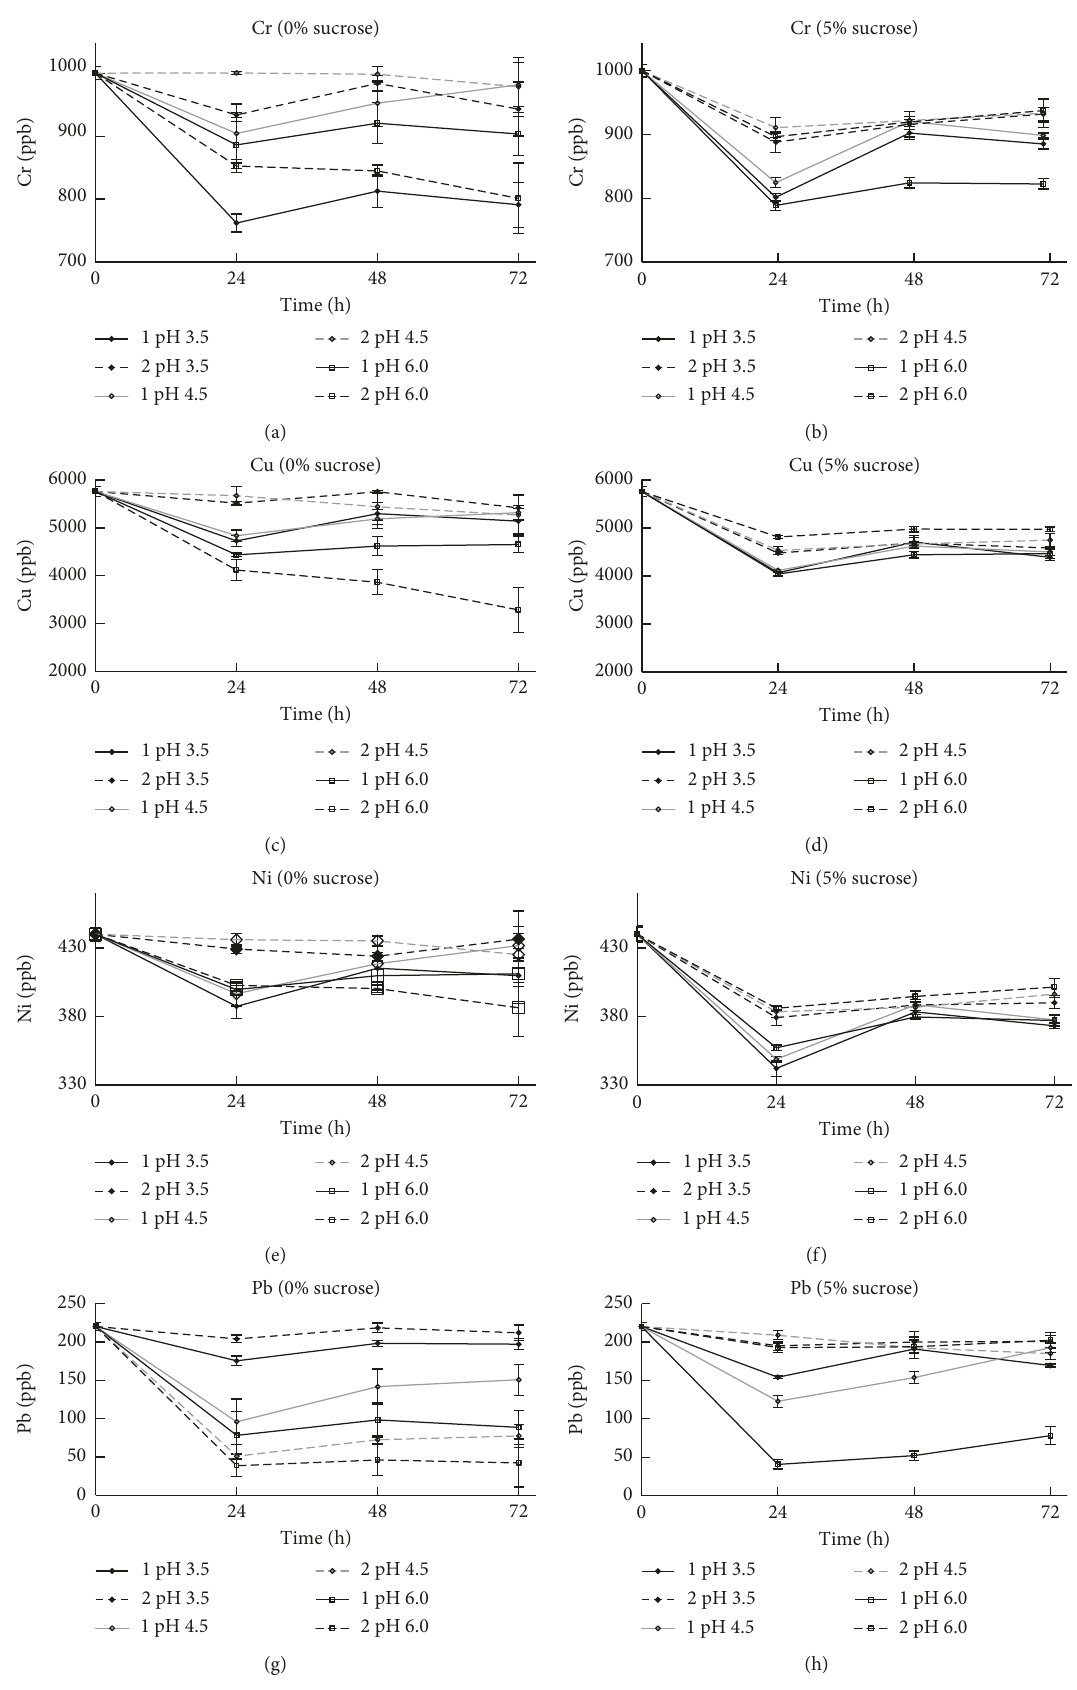
Figure 4: Cr, Cu, Ni, and Pb concentration as a function of time in absence and presence of sucrose (5%) for Colonies 1 and 2. Conditions: 5 · 10 –3 M citrate buffer, initial pH � 3.5, 4.5, and 6.1, and 1:10 Water Kefir/metal solution ratio. Left: absence of sucrose. Right: presence of sucrose. n �